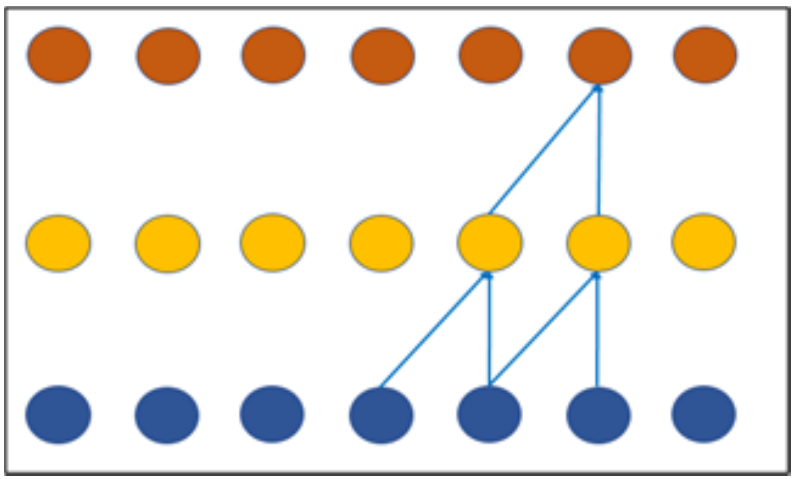
Figure 3. Example of causal